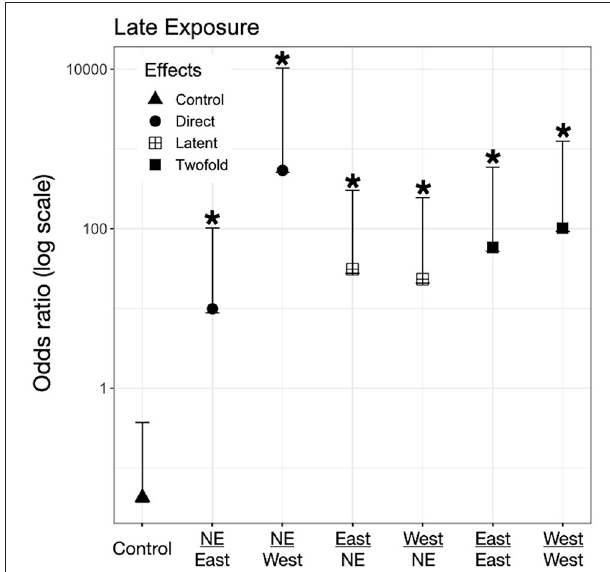
FIGURE 5 | Odds ratio (OR) for L. catesbeianus tadpoles according to their exposure regimes. Label of x-axis includes a fraction that indicates in the numerator the exposure regime as embryo and in the denominator exposure regime post-hatching. A star (*) indicates treatments with significant odds ratios. Effects are represented as follow: Direct effects –only exposed to Bd as larvae– are represented by circles, latent effects –only exposed as embryos– are represented as four squares, and 2-fold effects –exposed as embryos and larvae– are represented with filled squares; controls are represented by triangles.